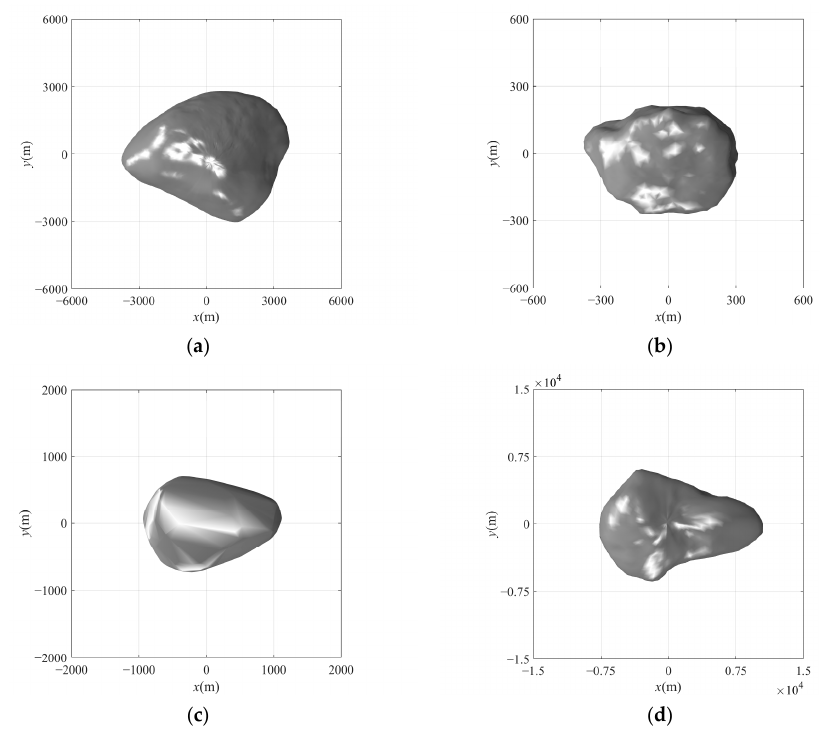
Figure 14. Polyhedral models corresponding to points 5–8 in Figure 12. ( a ) 9P/Tempel. ( b ) 6489 Golevka. ( c ) 3103 Eger. ( d ) 951 Gaspra.